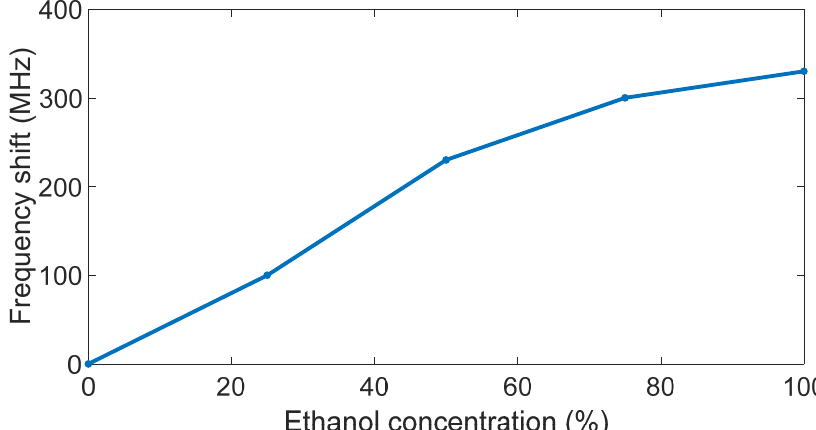
Figure 9. Antenna frequency shift versus ethanol concentration.